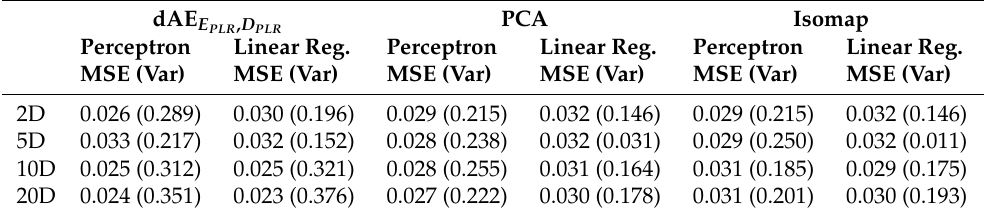
Table 4. Performance of the Medium model. MSE and Variance values are rounded to the third digit after the decimal sign.